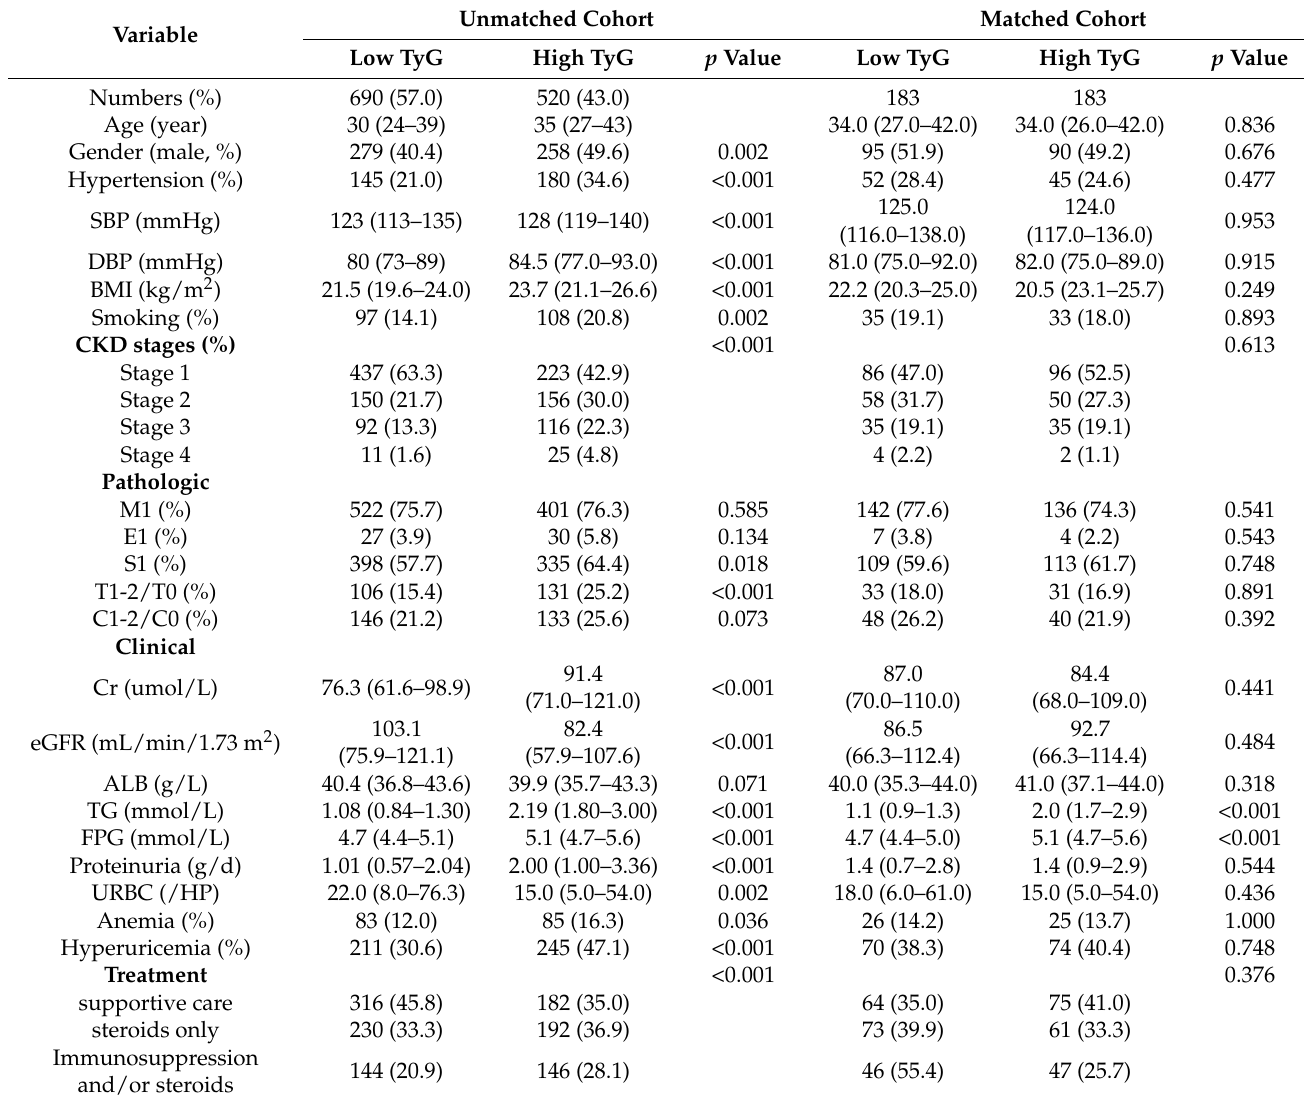
Table 1. Baseline characteristics of IgAN